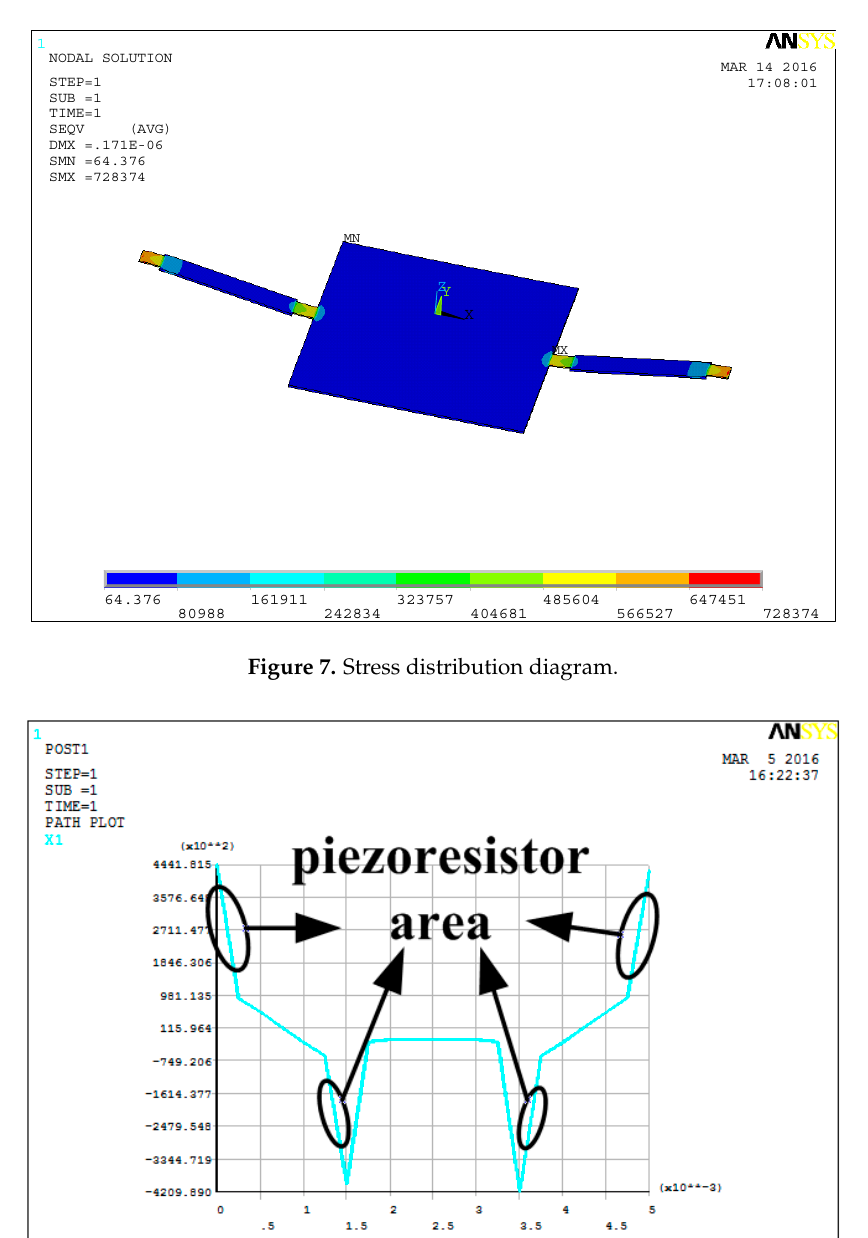
Figure 8. Stress distribution curve.